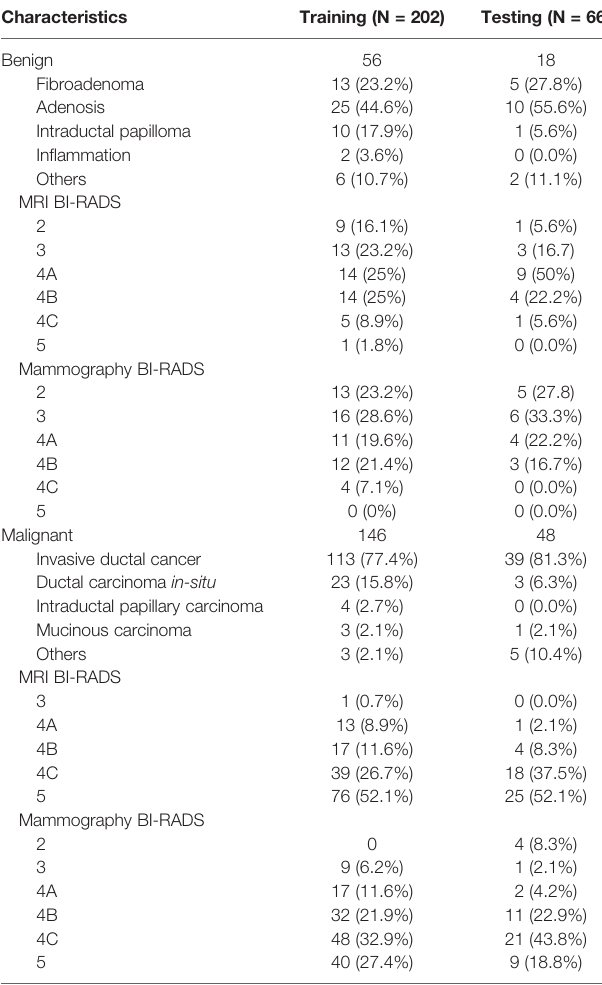
TABLE 1 | Pathological types and BI-RADS scores of lesions in training and testing datasets.